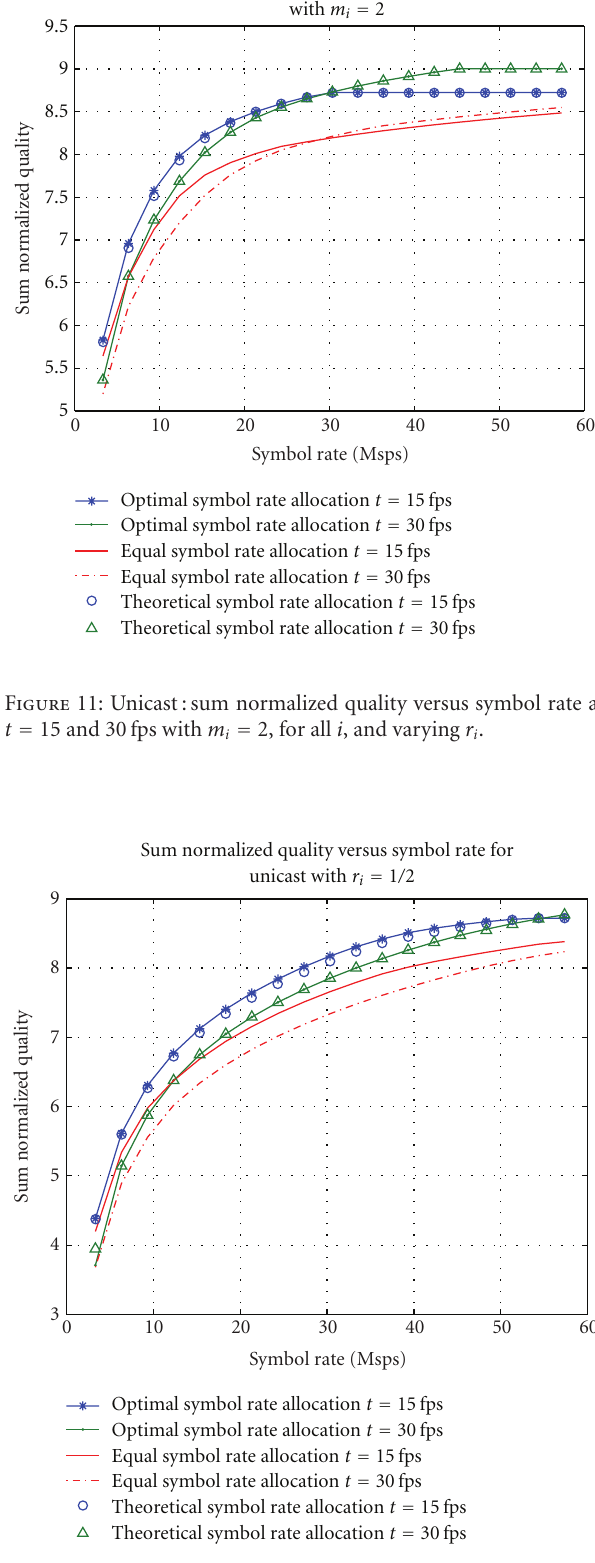
Figure 12: Unicast :sum normalized quality versus symbol rate at / 2, for all i , and varying m t = 15 and 30fps with r i = 1